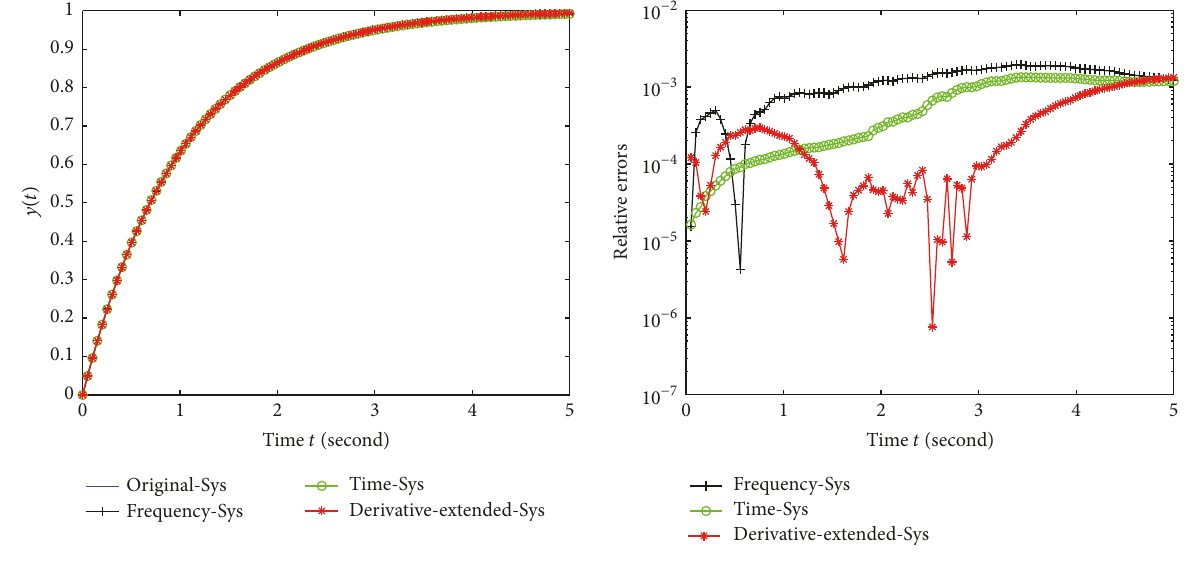
Figure 3: Outputs and relative errors for the input 𝑢(𝑡) = 𝑒 −𝑡 .